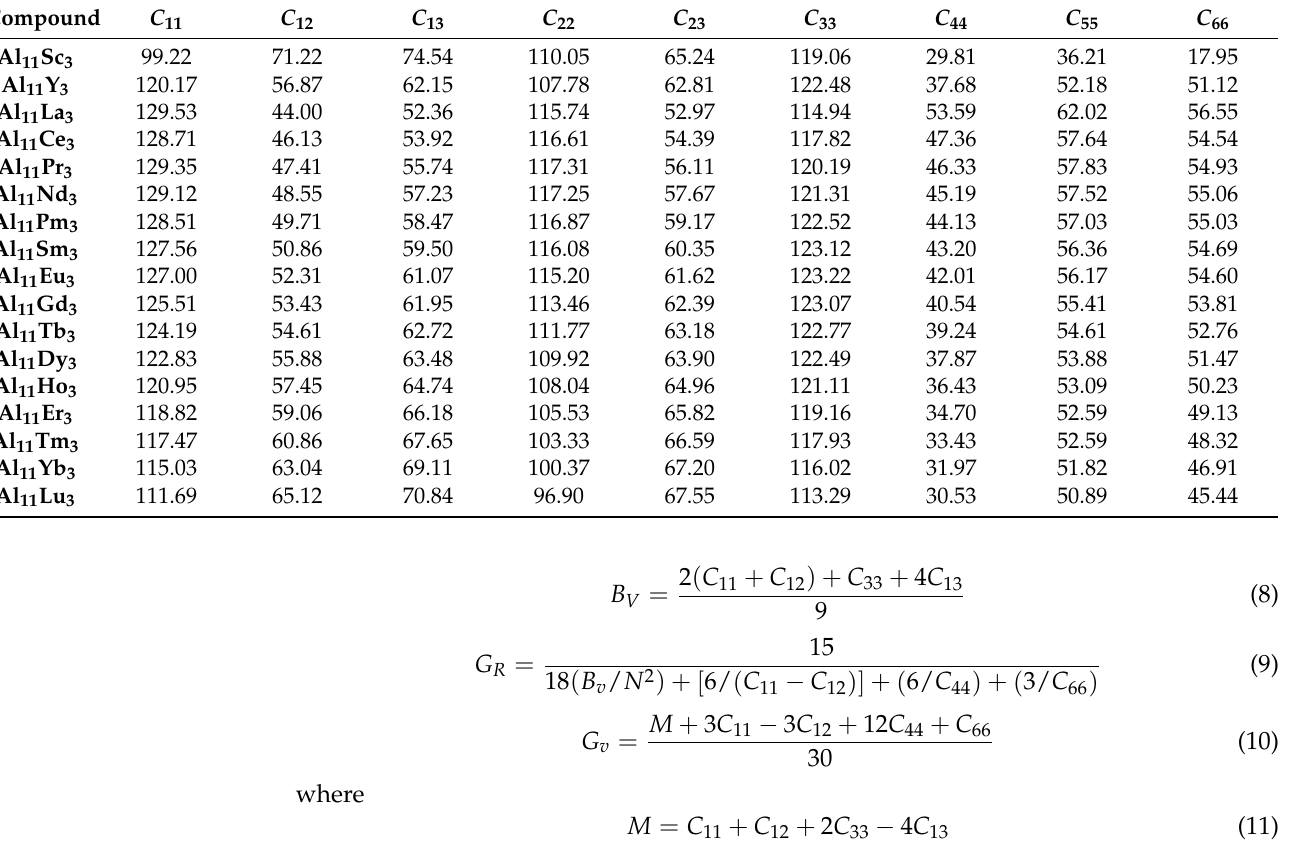
Table 1. The elastic constant C ij of Al 11 RE 3 intermetallics (units: